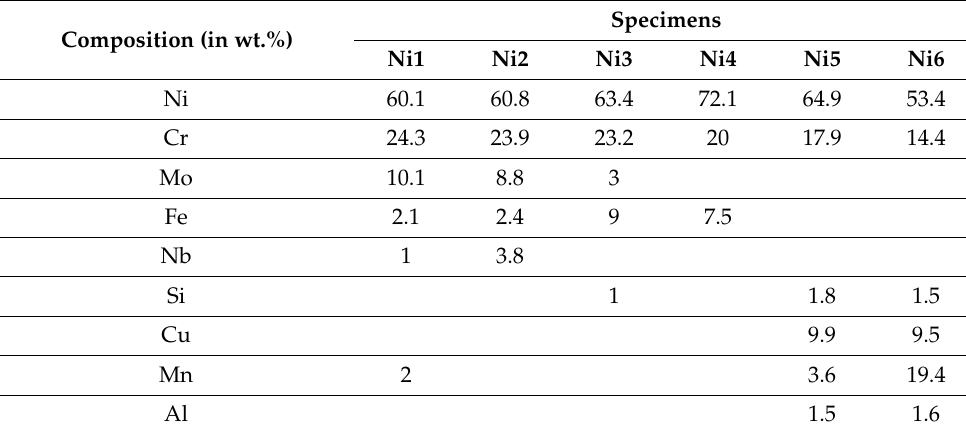
Table 1. NiCr dental material composition. Composition (in